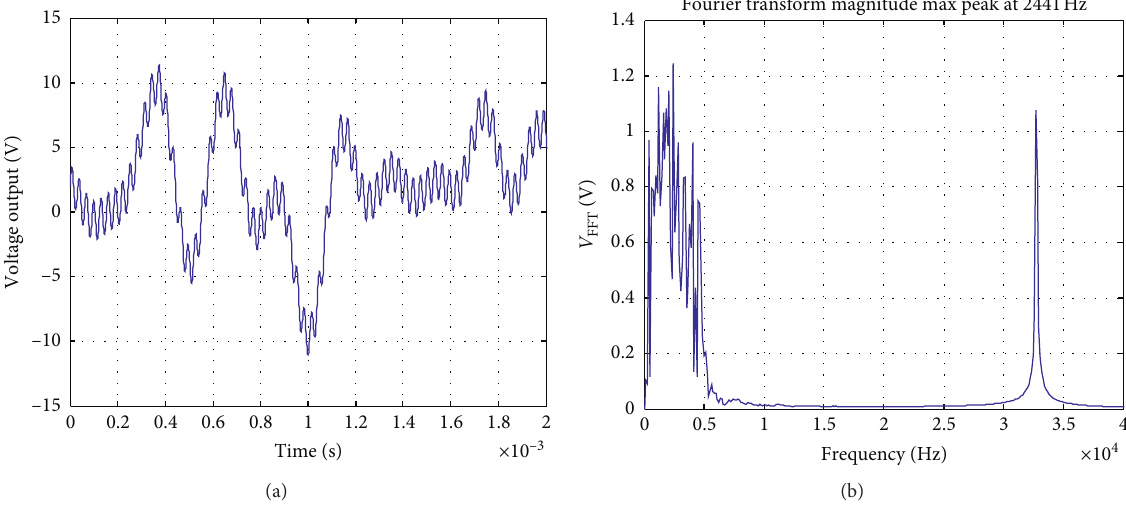
Figure 4: Frequency jumping of the crystal oscillator under external shock excitation. (a) Signal with noise. (b) Signal in the frequency domain.